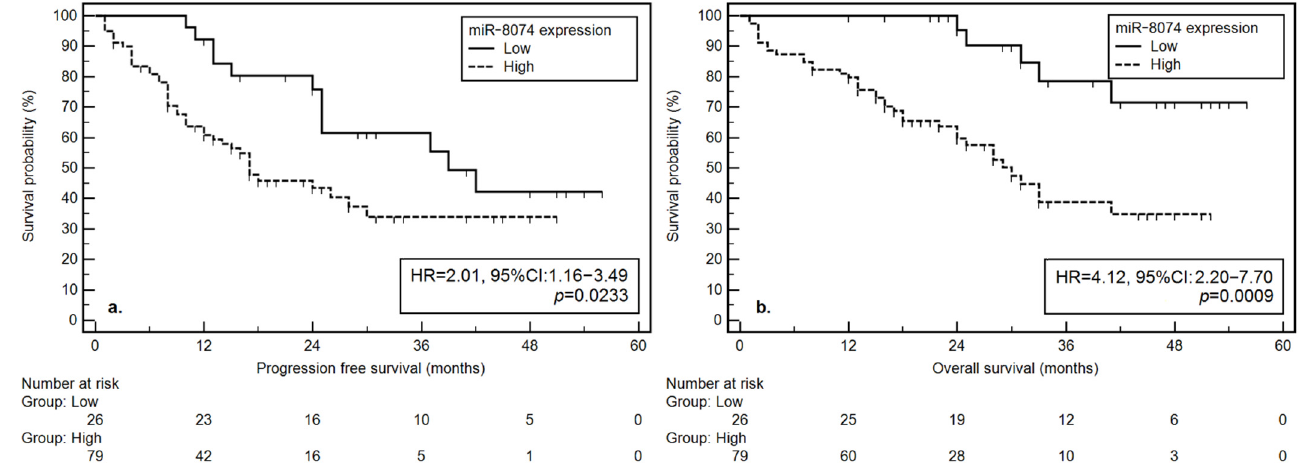
Figure 1. Kaplan-Meier curves from the analysis of miRNA-8074’s influence on ( a ) progression-free survival and ( b ) overall survival.